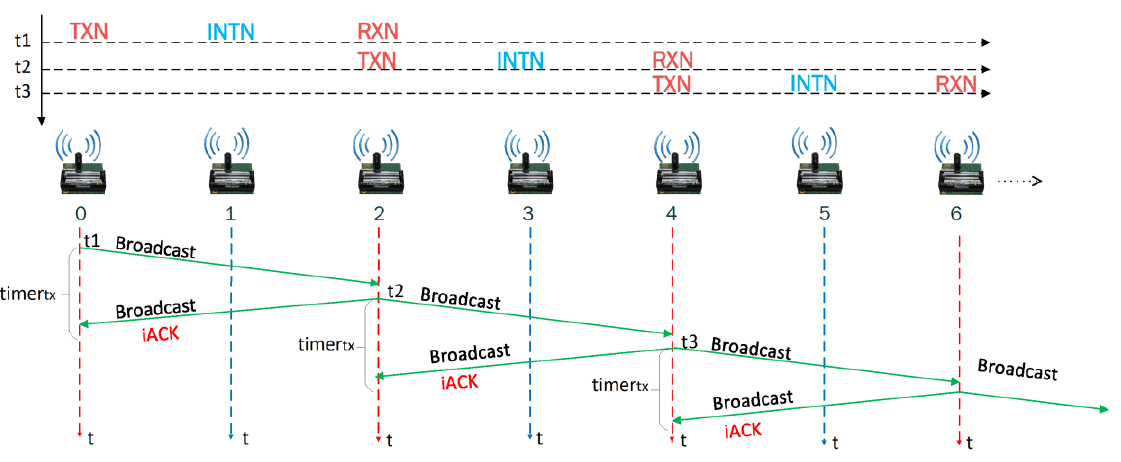
Figure 17. Tested network.